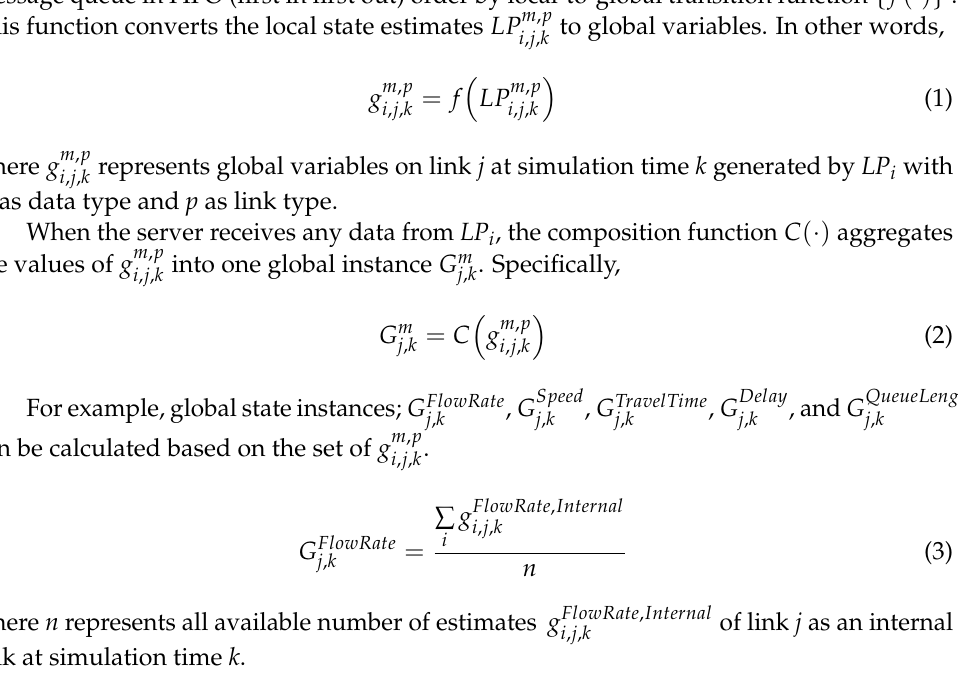
Table 3. Local and global process notation